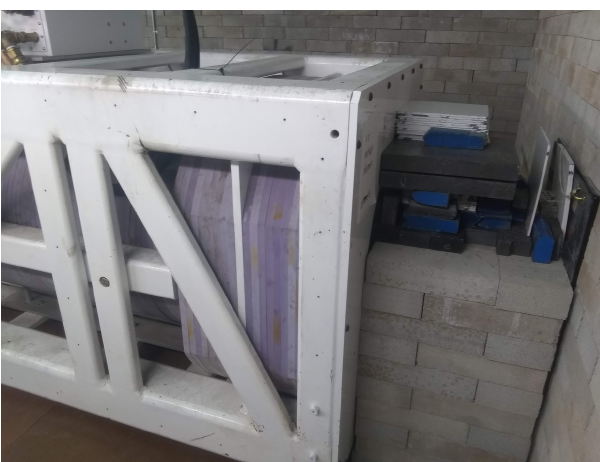
Figure 4. Detail of the output end of the Varian M9 linear accelera- tor at the Department of Nuclear Engineering and Radiological Sci- ences at the University of Michigan. The exit of the beam is located at the right-hand side of the figure, and the magnetometer being ir- radiated is located behind the wall on the right.